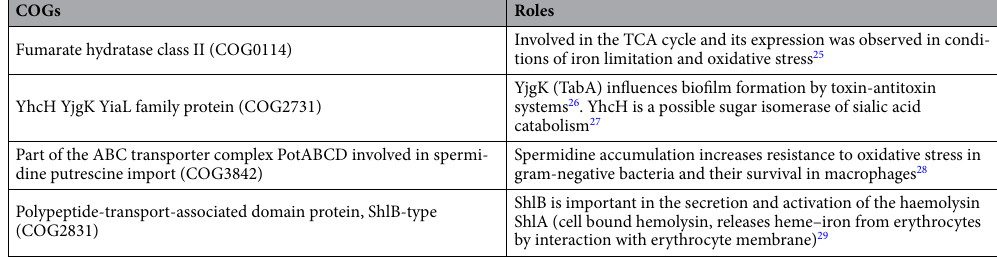
Table 1. Significantly increased microbial functions in the Piga-/- mice gut microbiota that might help these bacteria in their survival in an inflamed gut.